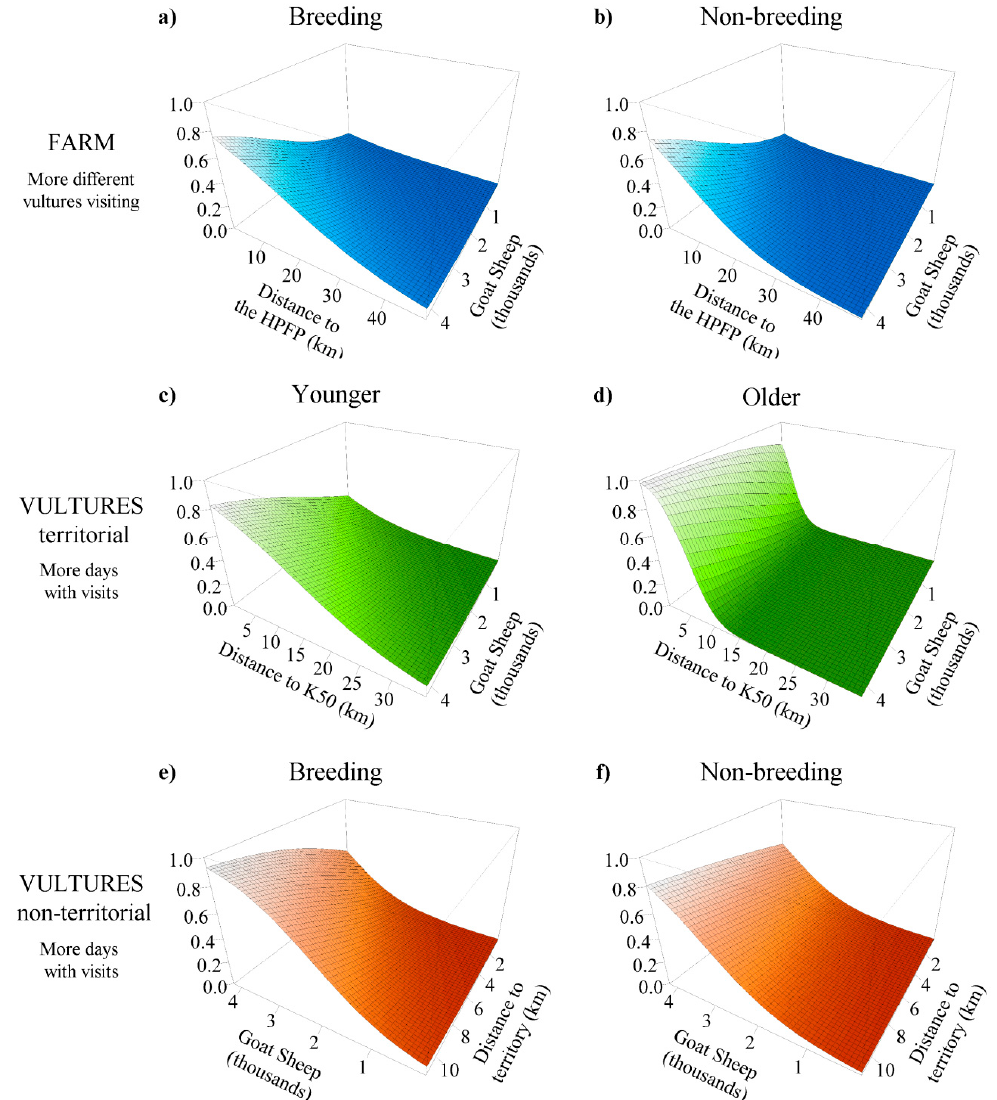
Figure 4. E ff ects of interacting variables in top-ranked models analyzing visits to farms by Egyptian Vultures. E ff ects of farm size (number of goats or sheep) on the probability of response variables: on top, FARM variable according to the distance to the nearest highly predictable feeding place ( Dist HPFP ) and season ( a ) breeding vs. ( b ) non-breeding, in the middle, VULTURE territorial variable regarding the distance to the nearest occupied territory ( Dist Terr ) and the ( c ) minimum (younger) or ( d ) maximum (older) age range; on the bottom, VULTURE non-territorial variable regarding the distance to the nearest core area of each individual ( Dist K50 ) and season ( e ) breeding vs. ( f ) non-breeding. Values for explanatory variables in top-ranked models used in predictions are the mean of the range with some exceptions to clarify the e ff ects: for VULTURE territorial , Area K95 is the minimum of the range, Dist Terr is the maximun, Sex is male, and Breeding is breeding season; for VULTURE non-territorial, Dist K50 is the minimum of the range.